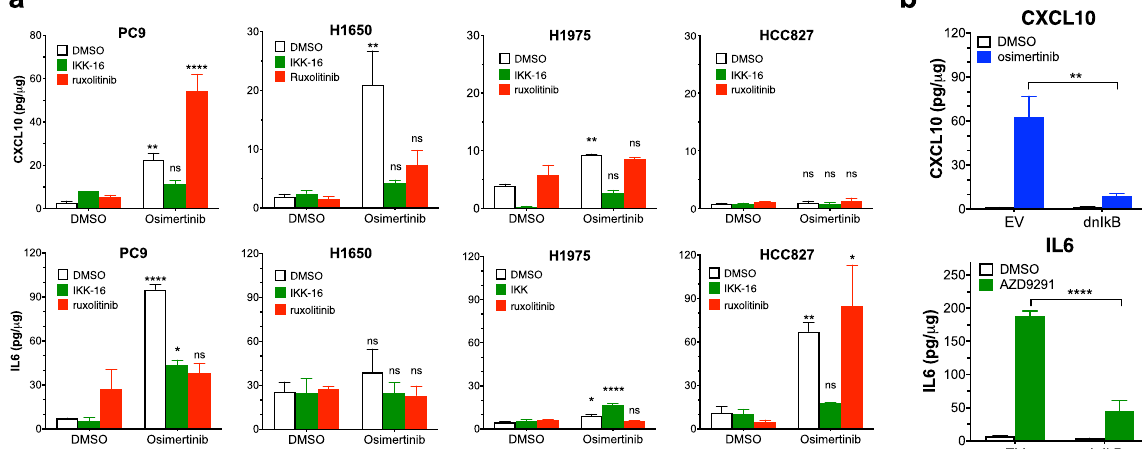
Fig. 3 Osimertinib-induced expression of CXCL10 and IL6 is NFkB and JAK/STAT pathway dependent. a PC9, H1650, H1975, and HCC827 cells were treated with DMSO or 300 nM osimertinib alone and in combination with 500 nM IKK16 or 500 nM ruxolitinib. All cell lines were treated for 7 days except PC9 cells which were treated for 3 days. Secreted CXCL10 and IL6 were measured by ELISA. The data are from three independent experiments and were submitted to one-way ANOVA and statistical signi fi cance of the osimertinib-treated samples relative to their DMSO controls is shown. b PC9 cells expressing the dnI κ B protein or empty vector as a control were treated with 300 nM osimertinib or DMSO control for 3 days and CXCL10 and IL6 protein secretion into the media was measured by ELISA. The data are the mean and SEM of three independent experiments and presented as pg/ μ g